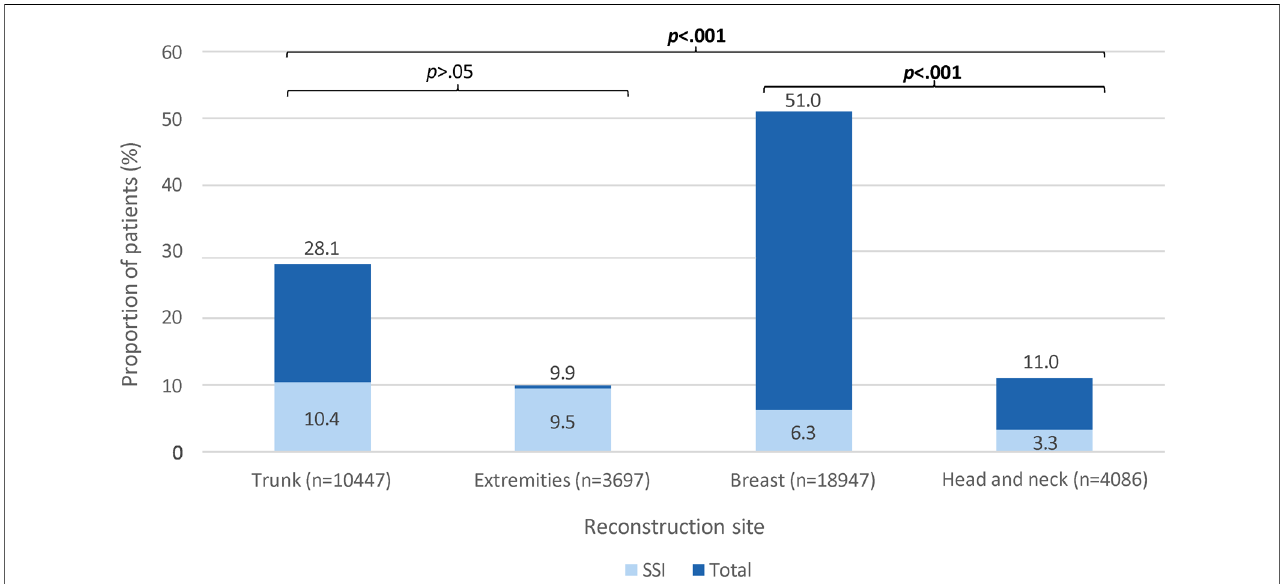
FIGURE 1 A stacked column chart showing the proportion of patients (%) who developed surgical site infection (light blue) among those who underwent reconstructive fl ap surgery (dark blue), strati fi ed by reconstruction site. SSI, surgical site infection. Dark blue bars show the proportions of patients who underwent reconstructive fl ap surgery, strati fi ed by reconstruction site. The proportions are calculated from the total number of patients who underwent reconstructive fl ap surgery ( n =37,177). Light blue bars show the proportions of patients who developed SSI following reconstructive fl ap surgery, strati fi ed by reconstruction site. The proportions are calculated from the total number of patients who underwent reconstruction of each respective site ( x -axis). These proportions are compared; signi fi cant p -values <.05 are